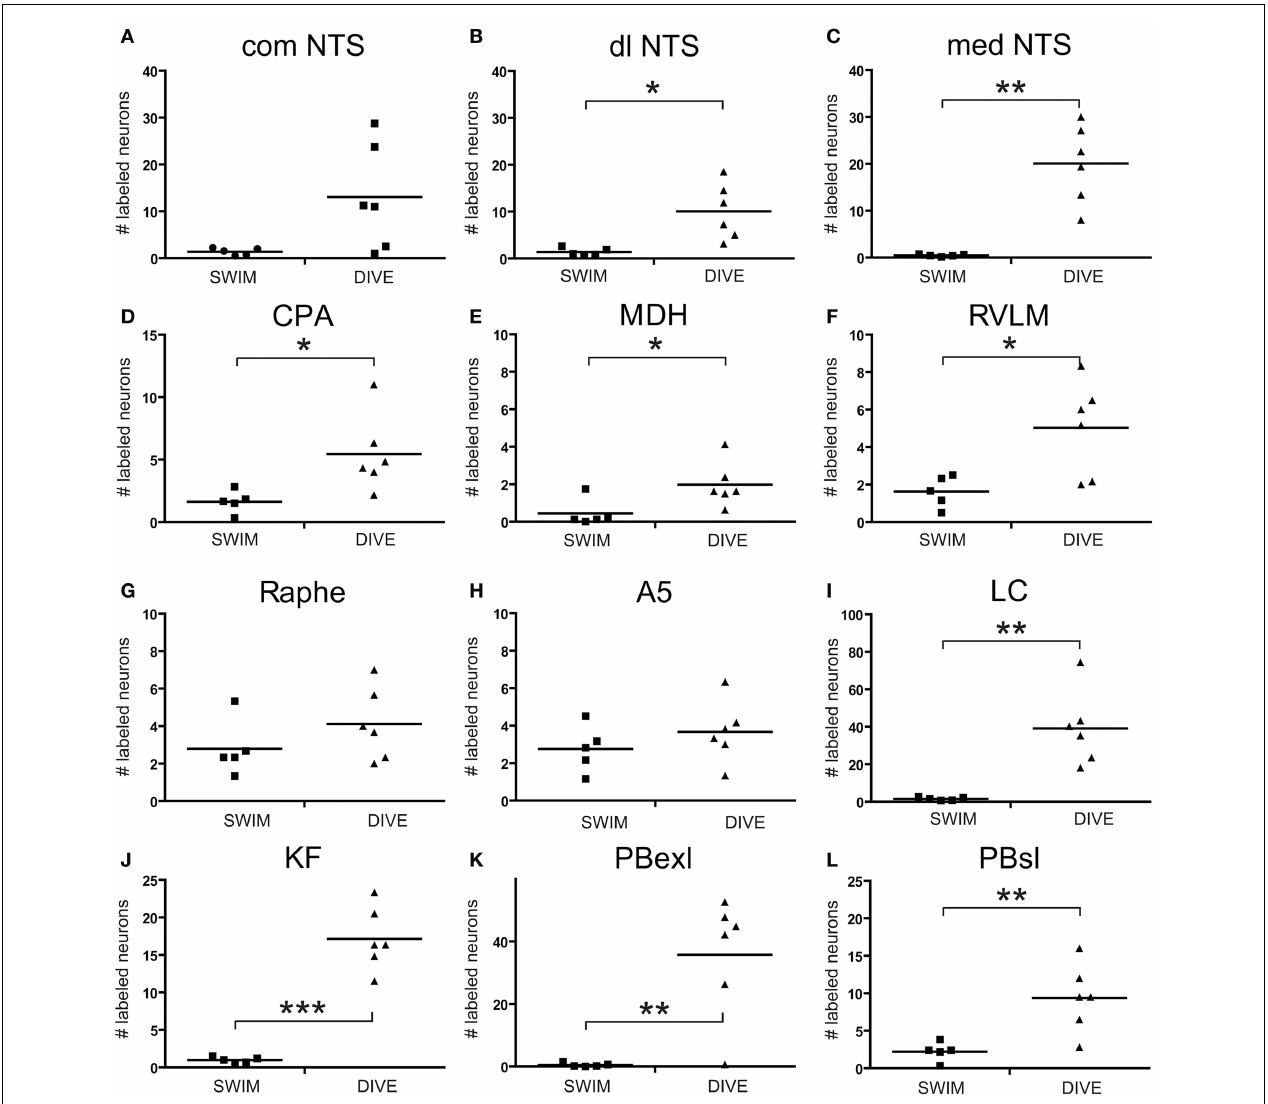
there was a significant increase after underwater submersion of discriminated data points in all nuclei but the comNTS, raphe, and A5 area. Square symbols mark data from individual swimming rats while triangles mark that from individual diving rats. Horizontal bars represent the mean.